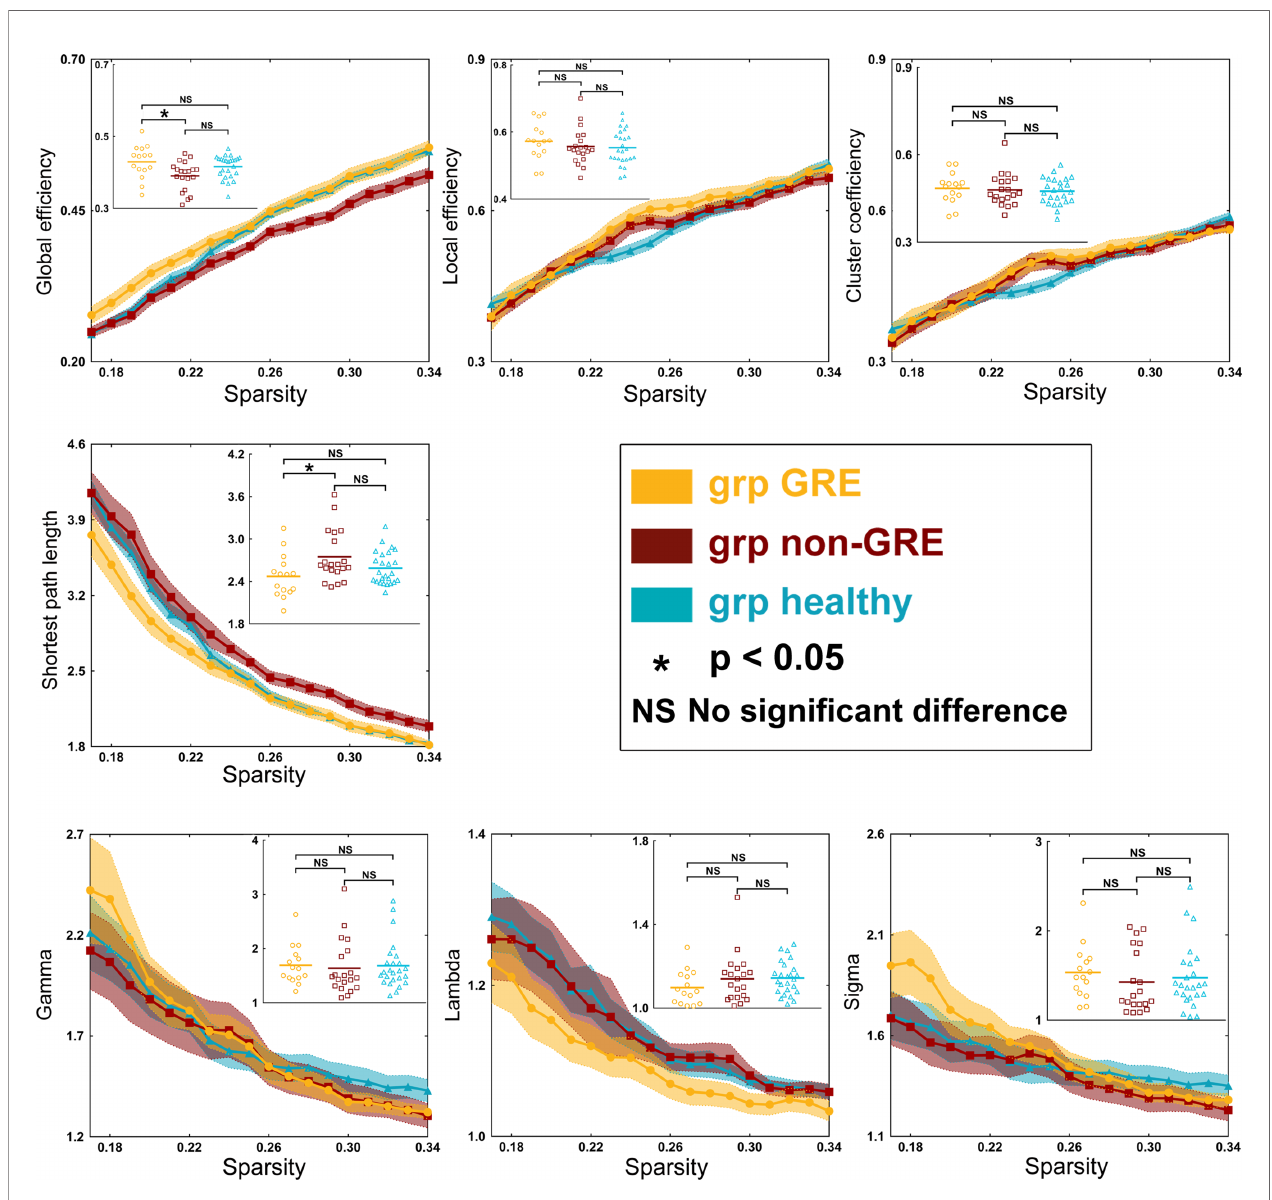
FIGURE 4 | Results of alterations in topological properties when gliomas grew in the left prefrontal lobe. Each property was analyzed with one-way ANOVA test and post-hoc test with least signi fi cant difference correction. The grp GRE (n = 15), group of patients with glioma-related epilepsy. The grp non-GRE (n = 20), group of patients without glioma-related epilepsy. The grp healthy (n = 25), group of healthy